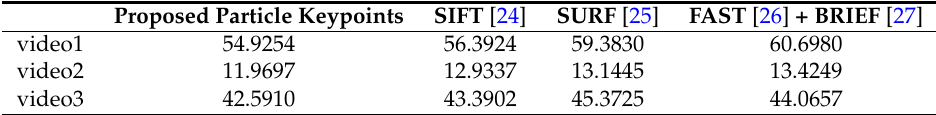
Table 1. Error of the estimated homography using four different feature detection